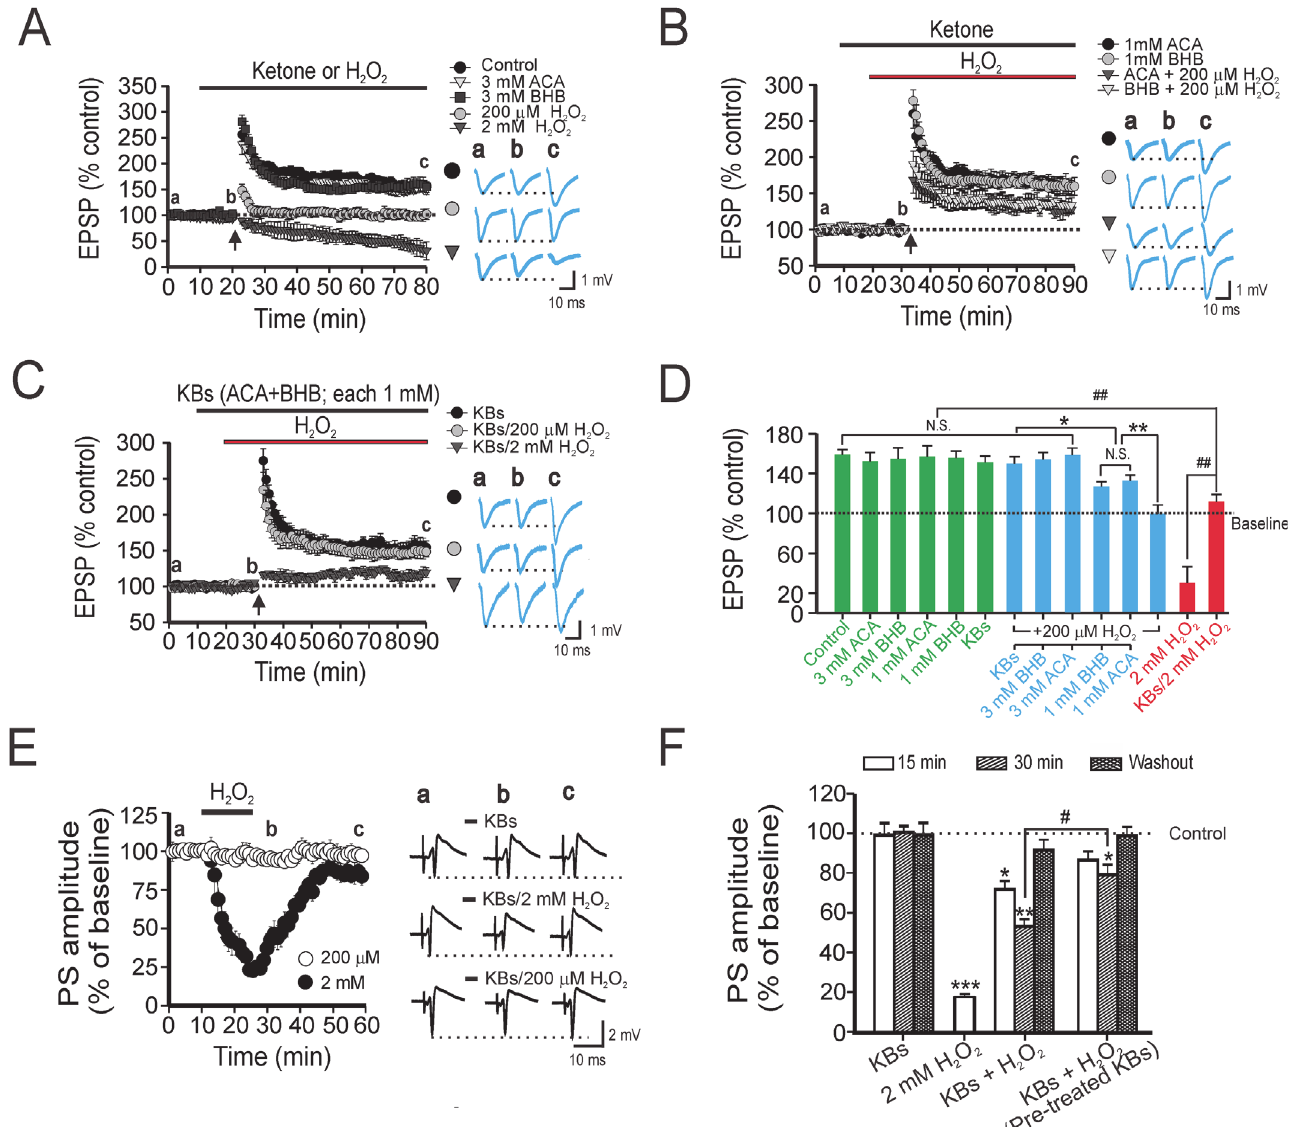
Fig 1. Ketones ameliorate synaptic impairment caused by hydrogen peroxide (H 2 O 2 ). (A) LTP recorded in rat CA1 hippocampal slices exposed to various concentrations of H 2 O 2 . Theta-burst stimulation (TBS) of schaffer collaterals led to robust LTP changes when either ACA or BHB (3 mM each) were perfused, but not with either 200 μ M or 2 mM H 2 O 2 . Representative traces of excitatory post-synaptic potentials (EPSPs) at respective time-points (a, b, c) depicted on the right of each panel. Vertical arrows in this and following figures indicate the time-point of TBS initiation. Dotted line denotes the baseline field potential amplitude which is the mean EPSP during a 10 min physiological saline infusion. (B) Only partial inhibition of LTP was observed when 200 μ M H 2 O 2 was co-applied with either ACA or BHB (1 mM each). (C) Intact LTP formation was seen when a cocktail of ketones (BHB and ACA, 1mM each) was used in conjunction with 200 μ M H 2 O 2 , but not with 2 mM H 2 O 2 . (D) Summary bar graph indicating changes in EPSP amplitudes at 60 min after TBS amongst various treatment groups. Dose-dependent protection by ketones against LTP impairment by H 2 O 2 -induced oxidative stress was seen in these experiments. Each vertical bar represents the EPSP amplitude ± SEM (obtained in 10 slices from 5 rats). One way ANOVA followed by Tukey post-hoc analysis; * , p < 0.05; ** or ## , p < 0.01, NS, not significant. (E) Acute application of H 2 O 2 results in depression of the population spike (PS) in stratum pyramidale of Cornu Ammonis (CA)1. Shown are changes in the mean ( ± SEM) PS amplitude before, during, or after H 2 O 2 infusion, but only when 2 mM H 2 O 2 was used. Representative traces of the PS alone ( top ), or co-applied with 2 mM H 2 O 2 ( middle ) or 2 mM H 2 O 2 ( bottom ) depicted on the right. Pre-incubation with ketones potentiated the restoration of PS amplitude compared to co-application of ketones with H 2 O 2. (F) Summary of amplitude changes in the PS (reflected as % of baseline) during or after drug application. Each vertical bar represents PS amplitude ± SEM, and data were collected from 12 slices from 5 rats. The dotted line reflects the baseline (100%) control PS amplitude before drug treatment. Asterisks denote significant differences between control and treatment groups ( * , p < 0.05; ** p < 0.01; *** , p < 0.001), whereas # indicates significant differences between the ketones plus H 2 O 2 group, and other groups in which pretreatment of ketones occurred before H 2 O 2 application ( p < 0.05).